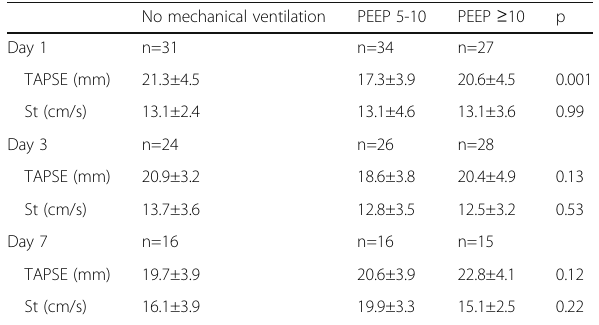
Table 2 (abstract 0338) . Differences in TAPSE and St, based on PEEP